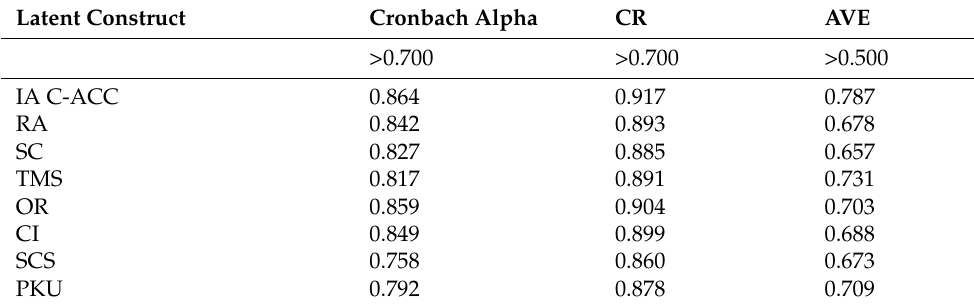
Table 3. Reliability of